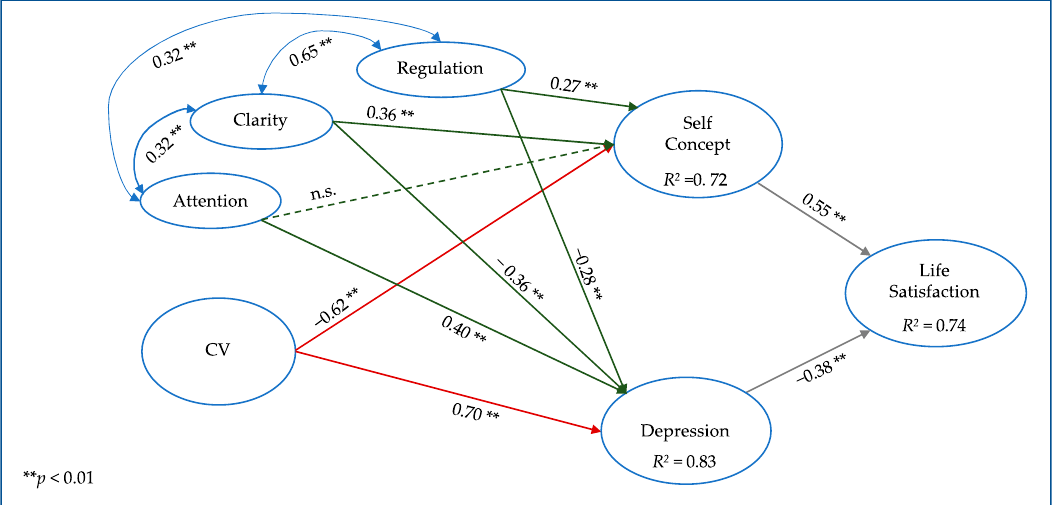
Figure 3. Model 3: Relationships between cybervictimization (CV) and the three components of emotional intelligence (EI) with emotional adjustment constructs. n.s.: non-significant coefficient.